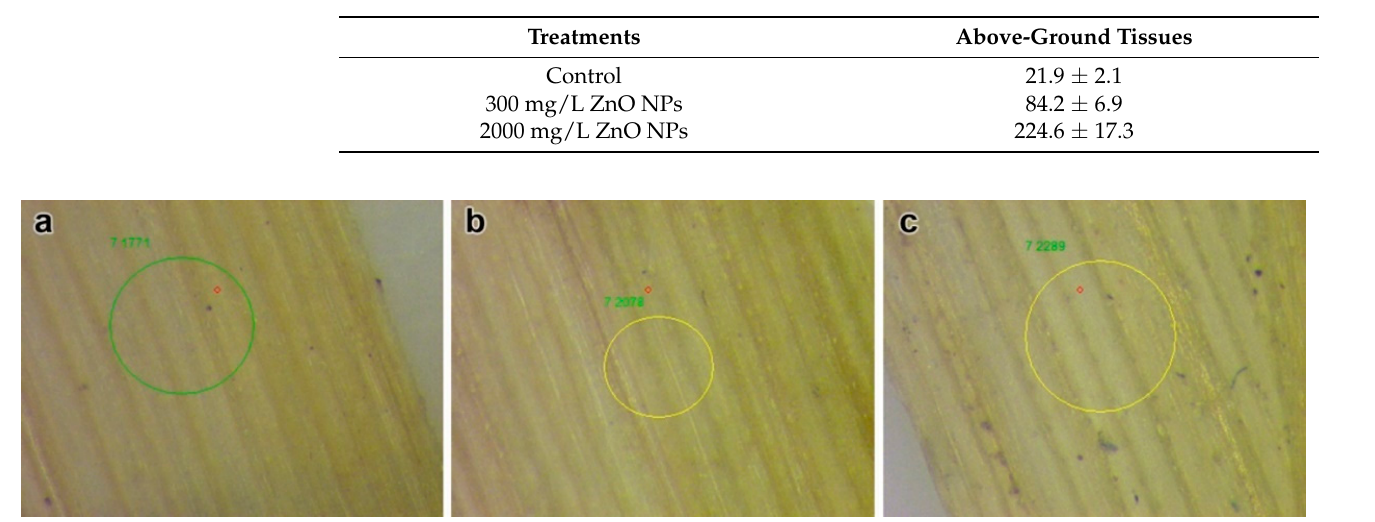
Figure 4. Zinc content of leaves by selecting plots using X-ray fluorescence spectroscopy. Images: ( a ) control, ( b ) 300, and ( c ) 2000 mg/L ZnO NPs.